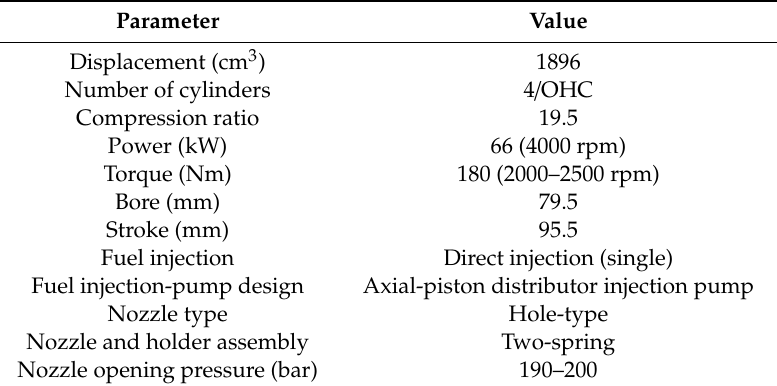
Table 3. Main parameters of a VW-Audi 1Z 1.9 TDI diesel